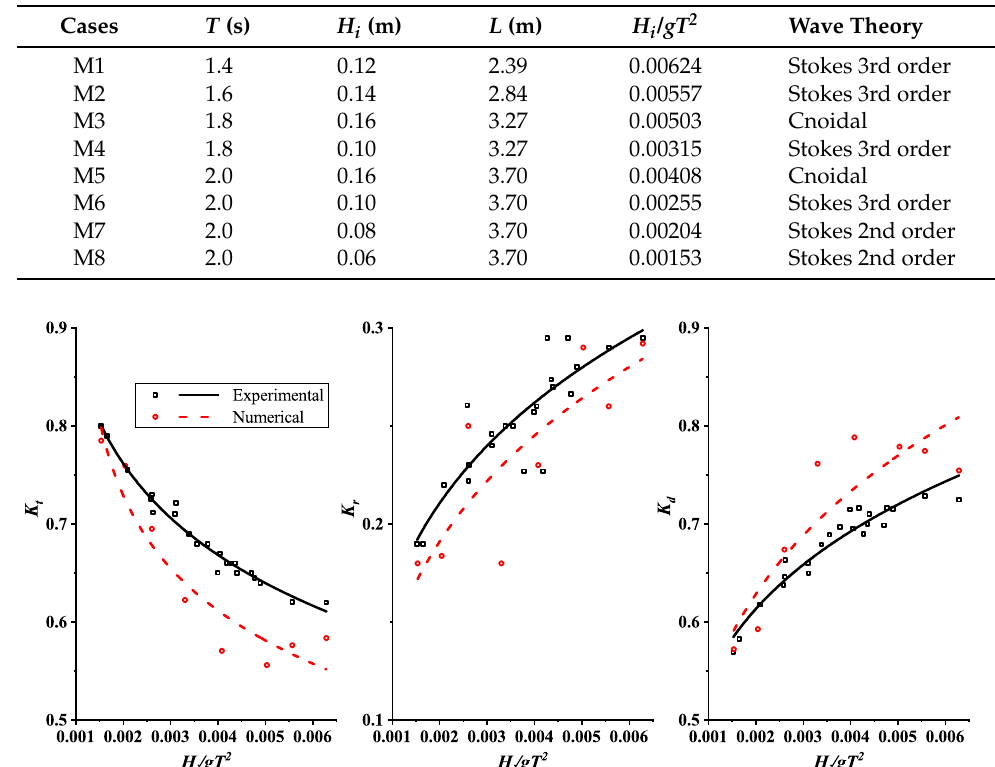
Table 3. Simulated cases of monochromatic waves.